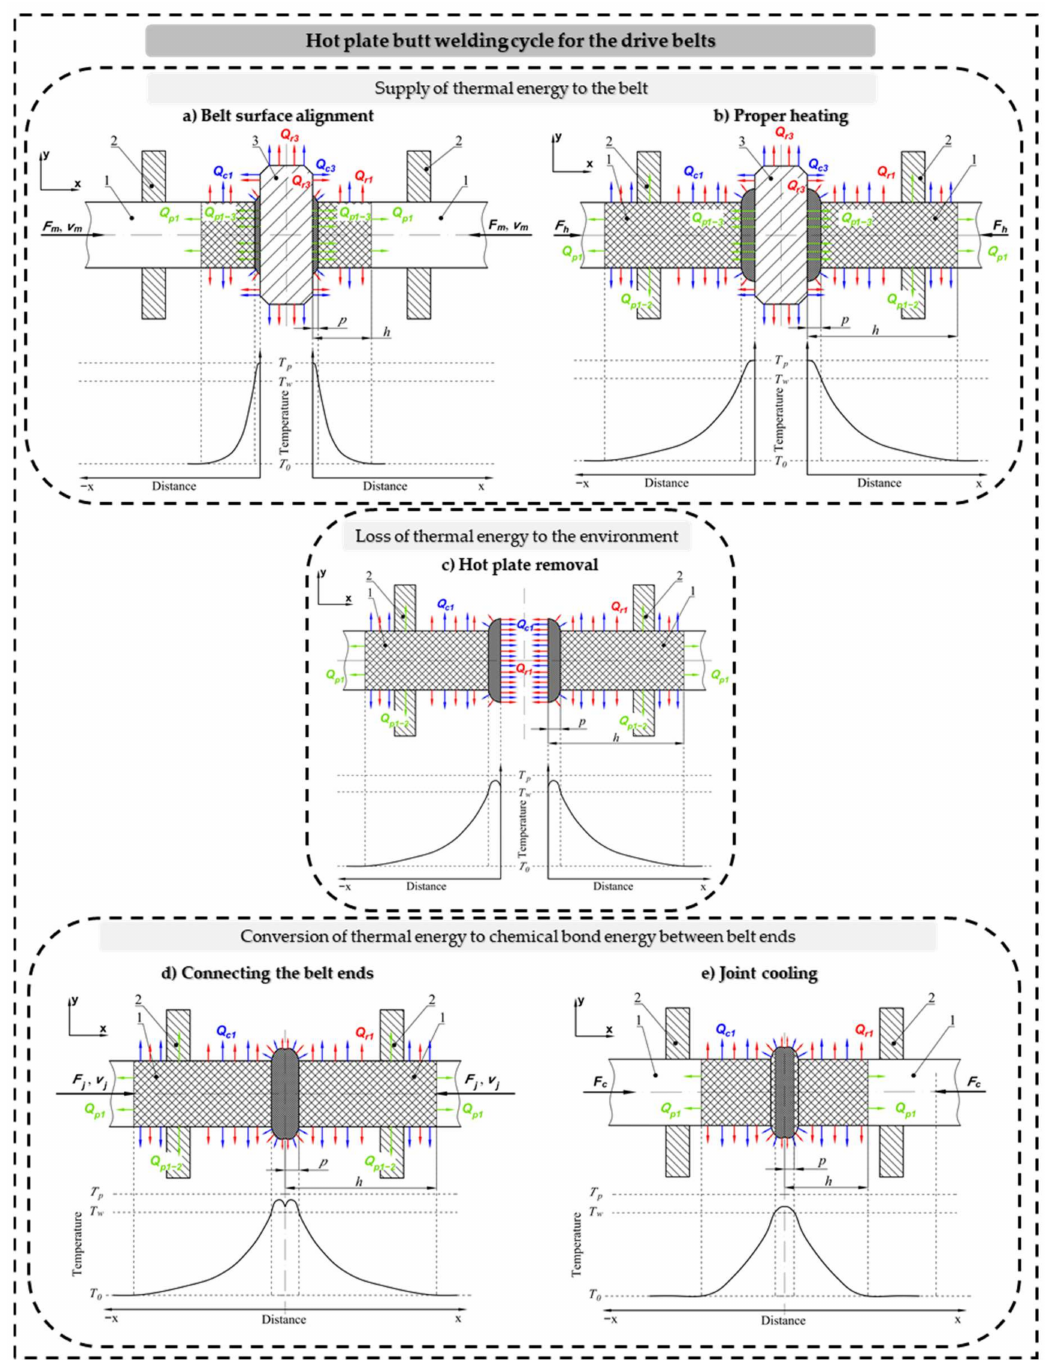
Figure 1. Hot plate butt welding cycle for the drive belts: ( a ) belt surface alignment, ( b ) proper heating, ( c ) hot plate removal, ( d ) connecting the belt ends, ( e ) joint cooling; 1—belt, 2—belt handle, 3—hot plate; F m —force aligning the belt on the hot plate, F h —force pressing the belt to the hot plate during heating, F j —force pressing the belt during joining, F c —pressing force during cooling of the joint, v m —velocity of pressing the belt ends to the hot plate during alignment, v j — velocity of pressing the belt during joining, T p —hot plate temperature, T w —welding temperature, T 0 —ambient temperature, p —belt plasticity distance, h —distance heated to temperature above ambient temperature; Q p 3-1 —heat conducted between the hot plate and the belt, Q p 1-2 —heat conducted between the belt and the handle, Q p 1 —heat conducted inside the belt material, Q r 1 —heat released from the belt to the ambient by radiation, Q r 3 —heat released from the hot plate to the ambient by radiation, Q c 1 —heat released from the belt to the ambient by convection, Q c 3 —heat released from the hot plate to the ambient by